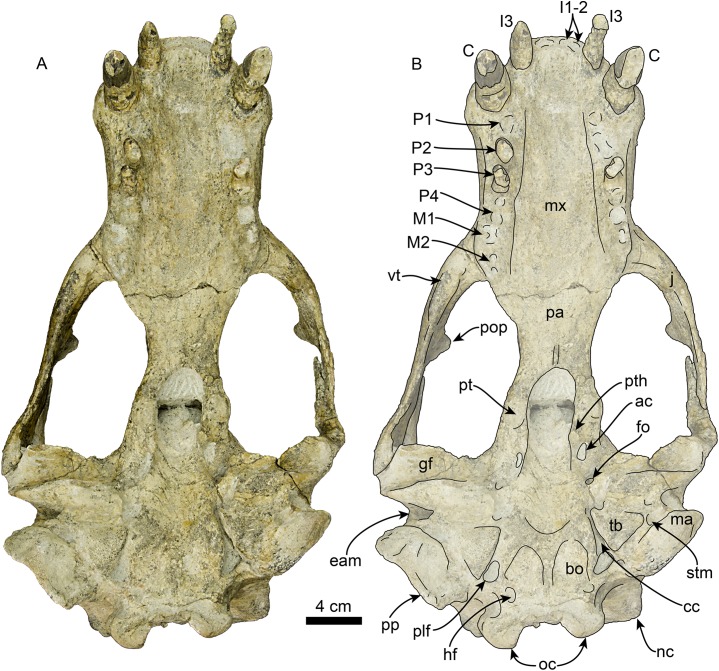
Skull of Titanotaria orangensis n. gen. et sp. (OCPC 11141).Skull in ventral view, without labels (A) and labelled (B). Abbreviations: ac, alisphenoid canal; bo, basioccipital; C, upper canine; cc, carotid canal; eam, external auditory meatus; fo, foramen ovale; gf, glenoid fossa; hf, hypoglossal foramen; j, jugal; I1–3, upper incisors 1–3; M1–2, upper molars 1–2; ma, mastoid; mx, maxilla; nc, nuchal crest; oc, occipital condyles; P1–4, upper premolars 1–4; pa, palatine; plf, posterior lacerate foramen; pop, postorbital process; pp, paroccipital process; pt, pterygoid; pth, pterygoid hamulus; stm, stylomastoid foramen; tb, tympanic bulla; vt, ventral tuberosity.